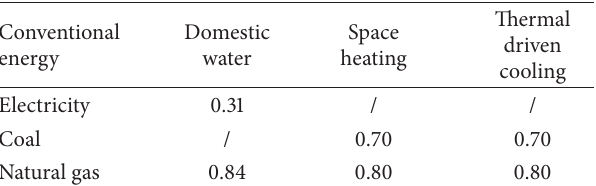
Table 5: Rank of the solar energy fraction for a solar water heating system in different solar energy resource regions.